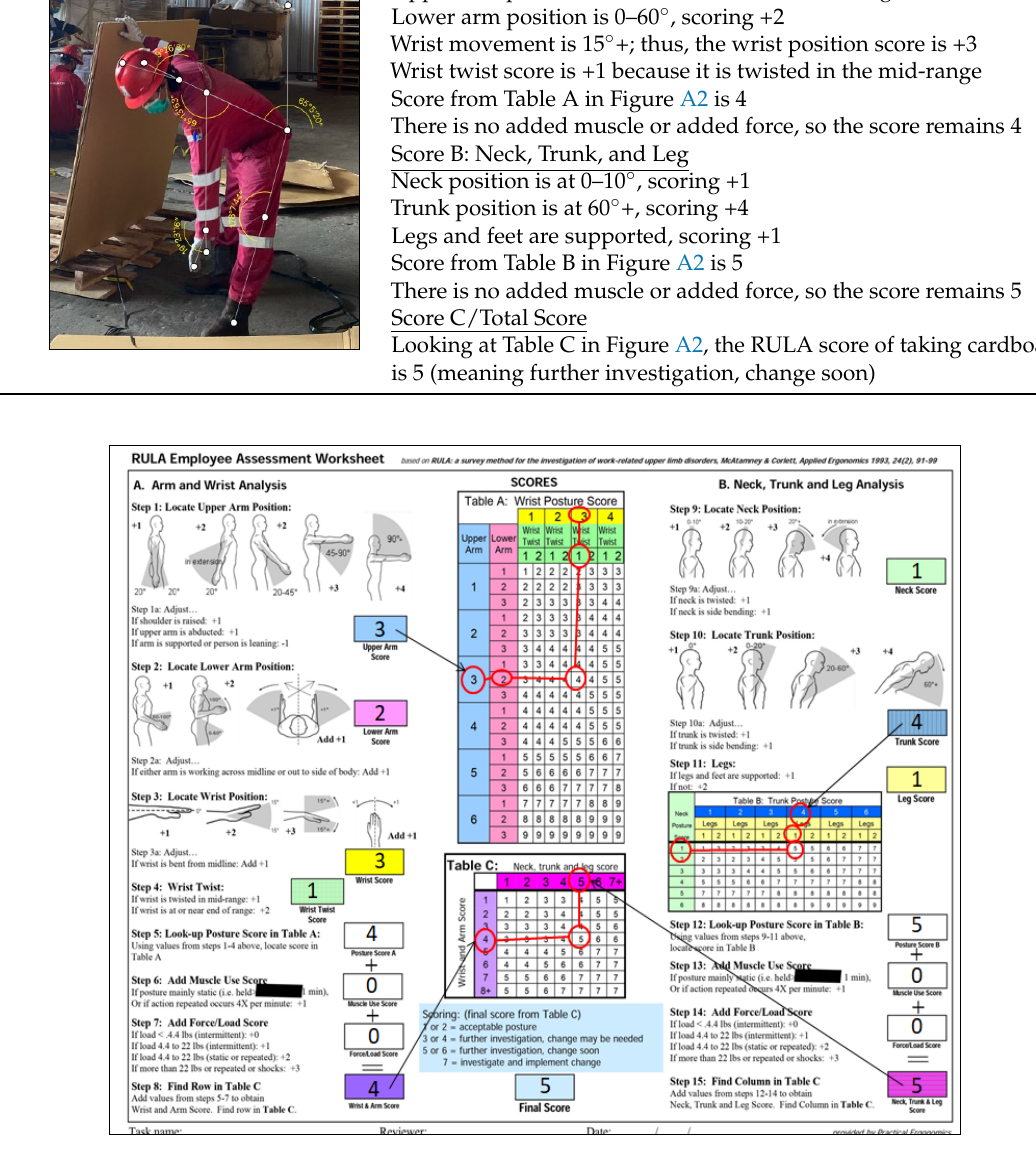
Figure A2. RULA employee assessment worksheet.